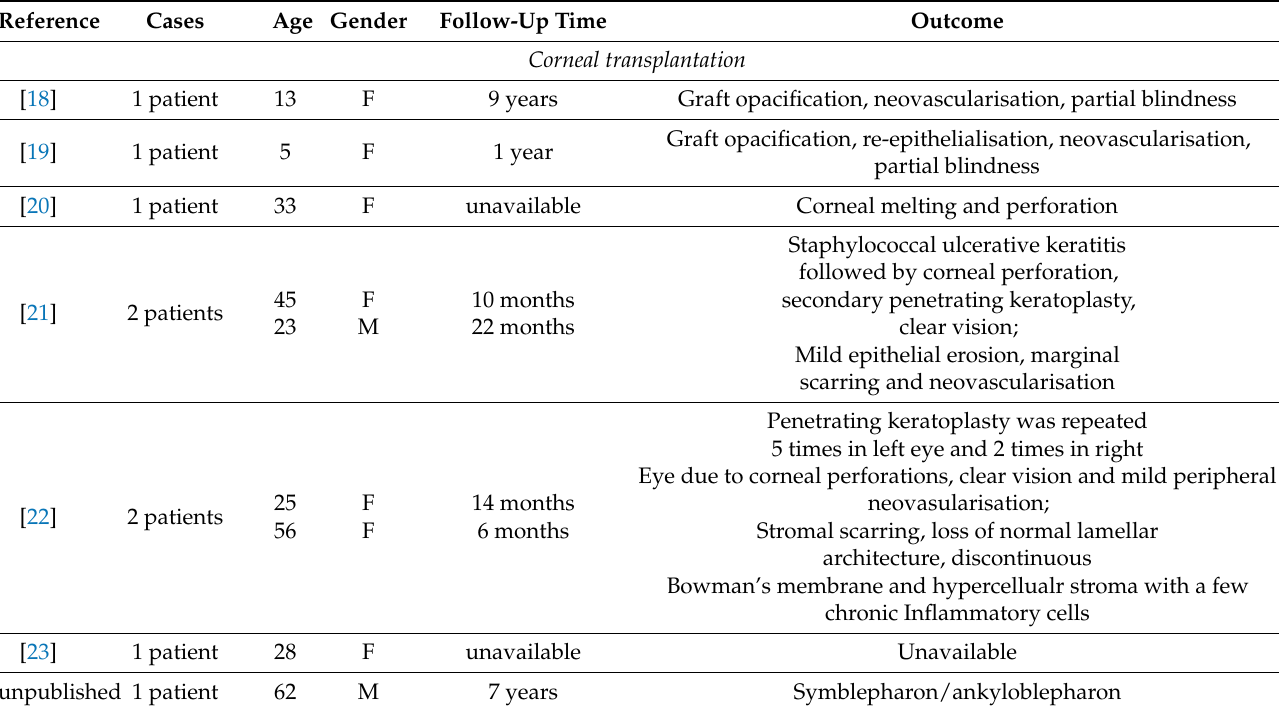
Table 1. Details, follow-up time and clinical outcome of EEC syndrome patients receiving penetrating